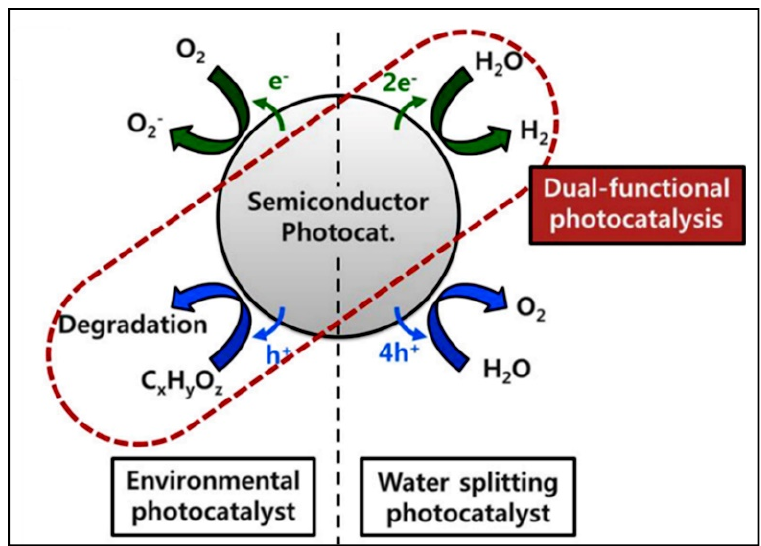
Figure 5. Dual-function photocatalysis process. Reprinted with permission from reference [158]. Copyright 2018 American Chemical Society.